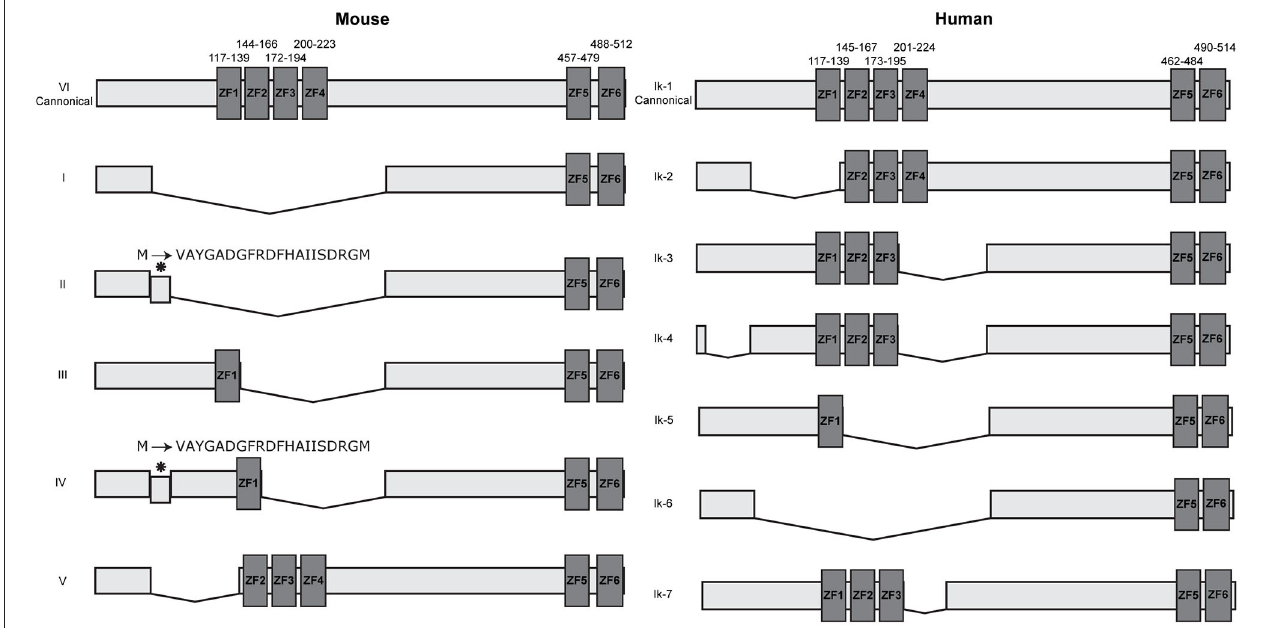
FIGURE 1 | IKZF1 isoforms in mice and humans. IKZF1 contains six zinc finger domains, with the first four at the N terminus (ZF1–ZF4) responsible for DNA binding, and the last two at the C terminus (ZF5 & ZF6) responsible for protein dimerization. Dark gray boxes indicate zinc finger domains, small numbers above indicate amino acid locations for zinc fingers. Data obtained from UniProt (IKZF1-mouse: Q03267 and IKZF1-human: Q13422), isoform numbers may differ across other